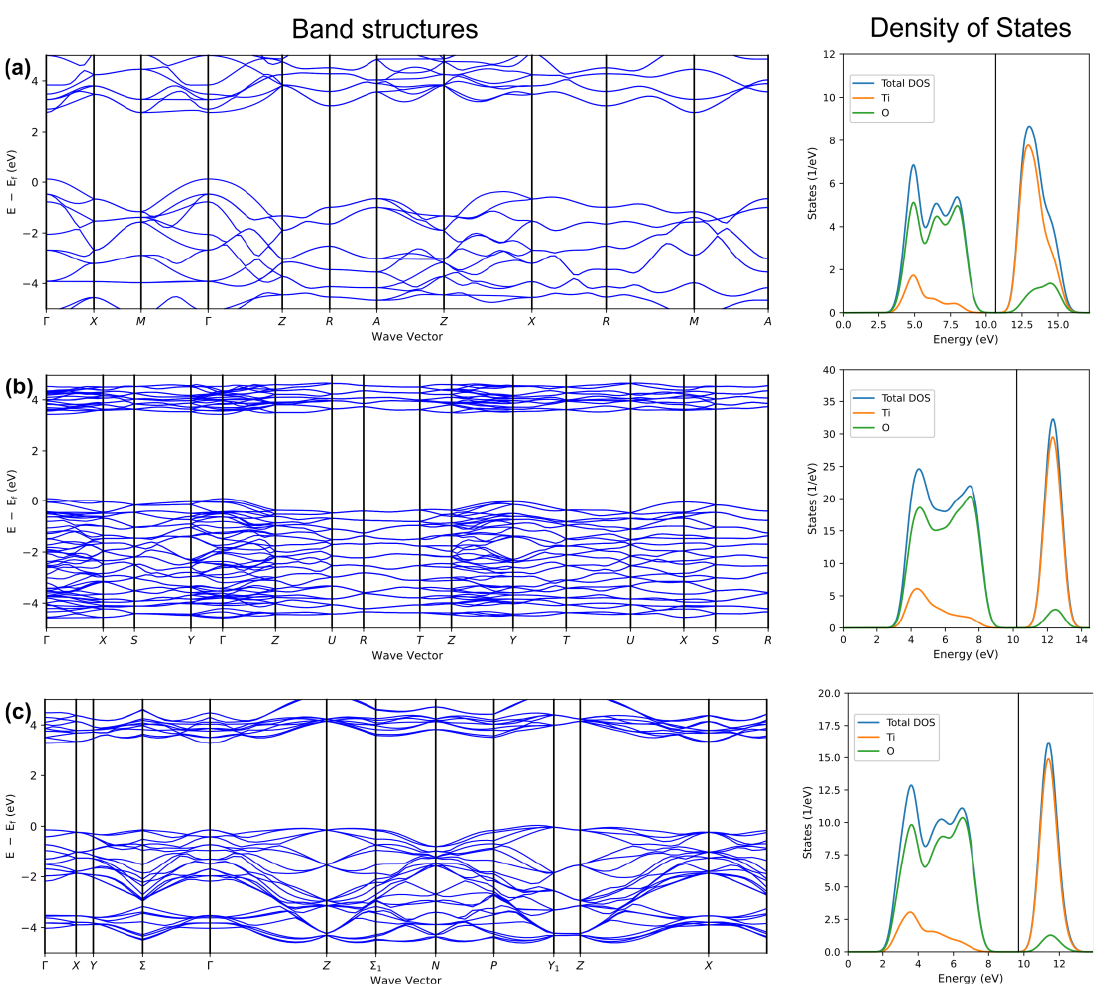
Figure 2. Band structures ( left panel) and projected density of states ( right panel) for the ( a ) rutile, ( b ) brookite, and ( c ) anatase polymorphs of TiO 2 , as obtained by DFT + U calculations (PBE functional, GBRV pseudopotentials, U = 7.8 eV, J = 1.0 eV) in Quantum Espresso program as implemented